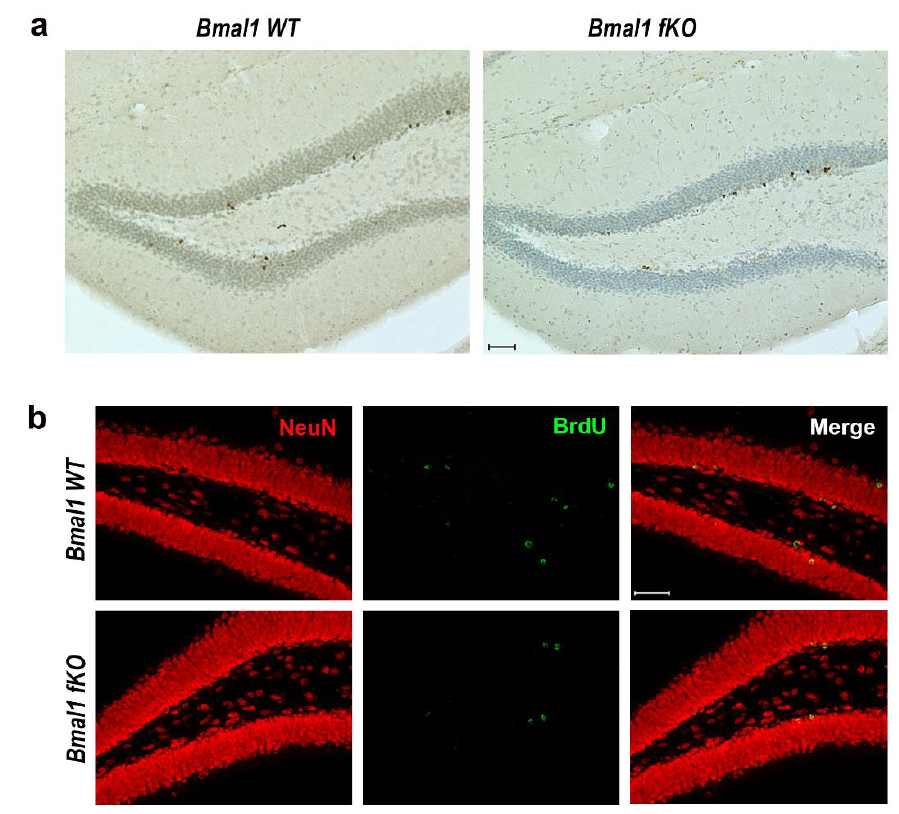
Figure 4. Survival and neural differentiation of proliferating neural progenitor cells in the dentate gyrus of Bmal1 fKO mice. ( a ) Representative photomicrograph of BrdU+ cells (brown) and cresyl violet staining (blue) in the dentate gyrus of Bmal1 WT and Bmal1 fKO mice. Scale bars = 50 µm. ( b ) Representative photomicrograph of BrdU+ (green) and the marker for mature neurons NeuN+ (red) in the dentate gyrus of Bmal1 WT and Bmal1 fKO mice. Scale bars = 50 µm.